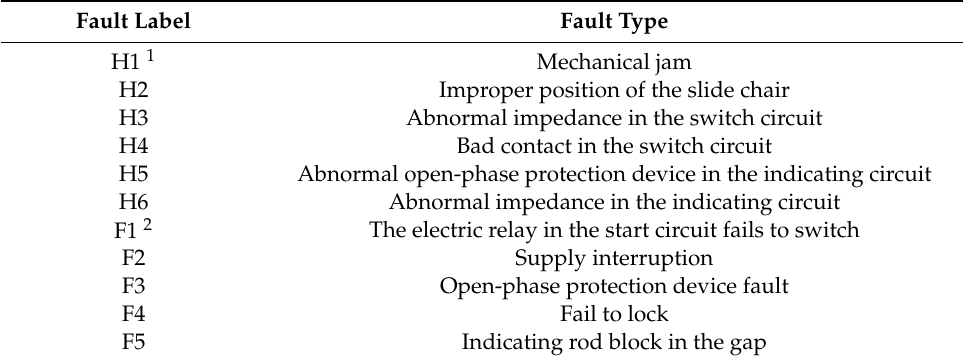
Table 1. Turnout fault types.